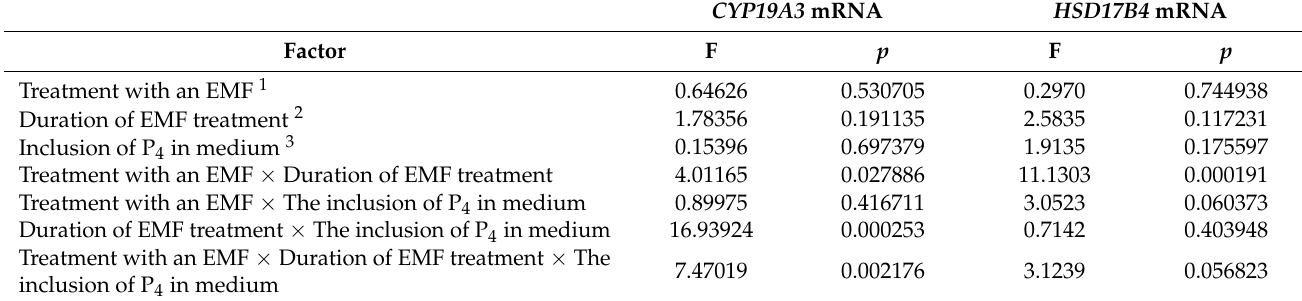
Table 1. The main factors and the interactions affecting the cytochrome P450arom ( CYP19A3 ) and 17 β hydroxysteroid dehydro- genase ( HSD17B4 ) mRNA transcript abundance in porcine myometrium collected from pigs during the peri-implantation period (days 15–16 of pregnancy) and treated in vitro with an EMF at 50 and 120 Hz for 2 and 4 h of incubation with or without the inclusion of P 4 (multi-way